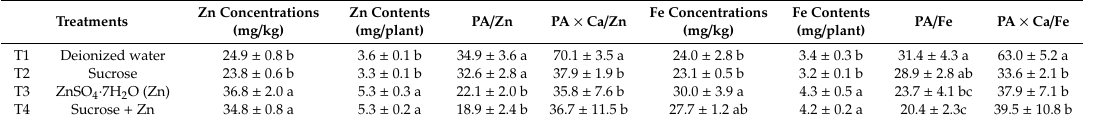
Table 5. E ff ects of di ff erent foliar treatments on Zn and Fe concentrations, contents and molar ratios of PA / Zn, PA × Ca / Zn, PA / Fe, and PA × Ca / Fe in maize grains in the field experiment at Licheng. Treatments ZnConcentrations (mg / kg) ZnContents (mg / plant) PA / Zn PA × Ca / Zn FeConcentrations (mg / kg) FeContents (mg / plant) PA / Fe PA × Ca / Fe T1